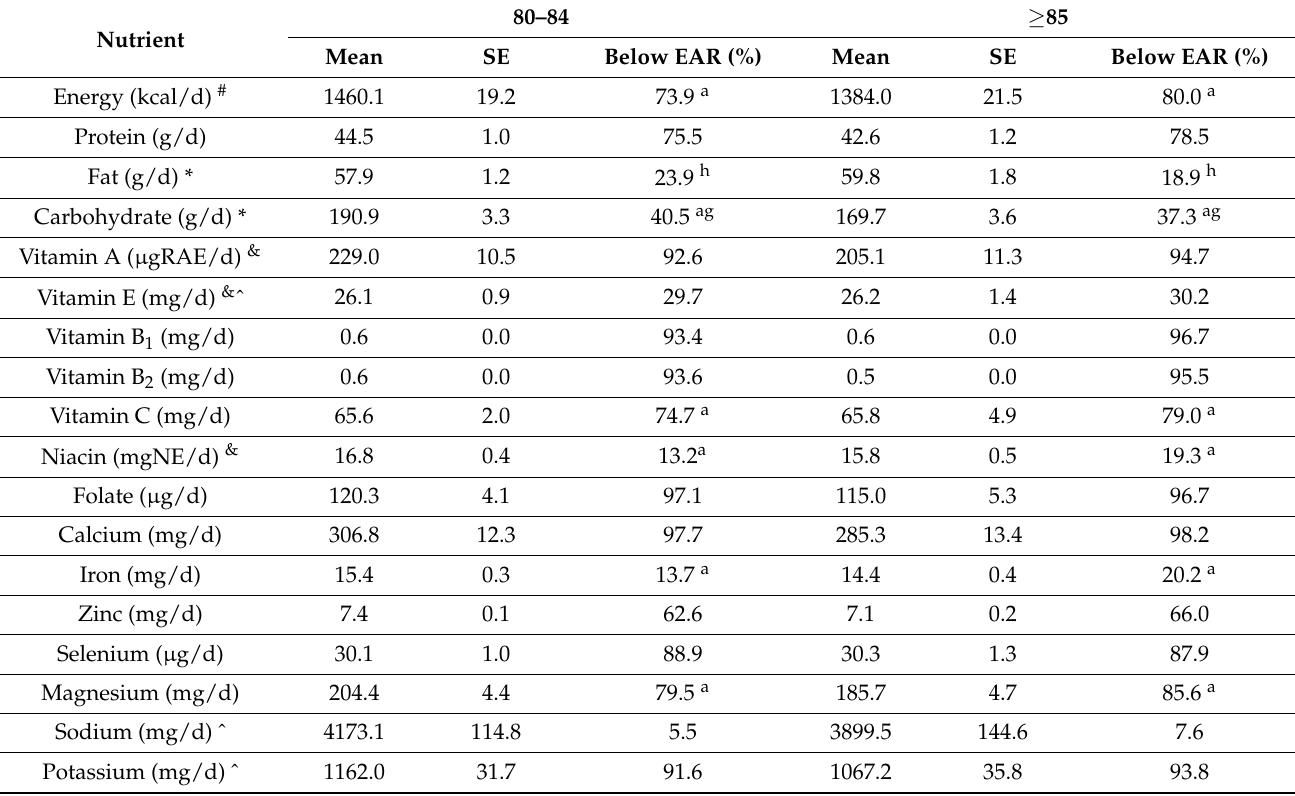
Table 3. Dietary daily intake of energy and nutrients and the prevalence of deficiency in the subjects aged 80 and above in different age groups.